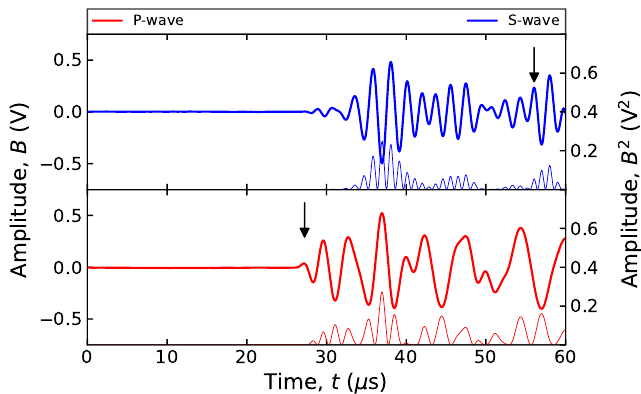
Figure 4. Examples of PT measured P- (red) and S-waveform (blue) amplitudes R (thick) and R 2 (thin) versus time t , respectively. Arrows indicate first arrivals.